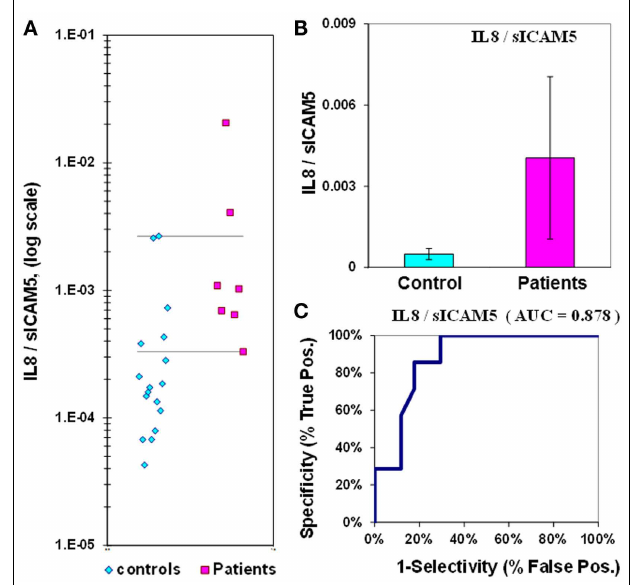
FIGURE 5 | IL-8/sICAM5 ratio in plasma from epilepsy patients and controls. (A) Dot-plot of IL-8/sICAM5 concentrations in plasma (square, patients; diamond, controls). For values between the horizontal lines, the assay does not accurately discriminate between patients and controls. (B) Bar graph and error calculation for data in Part (A) . Difference not significant, with p = 0.125. (C) ROC curve for data in Part (A) , showing an area under the curve (AUC) value of